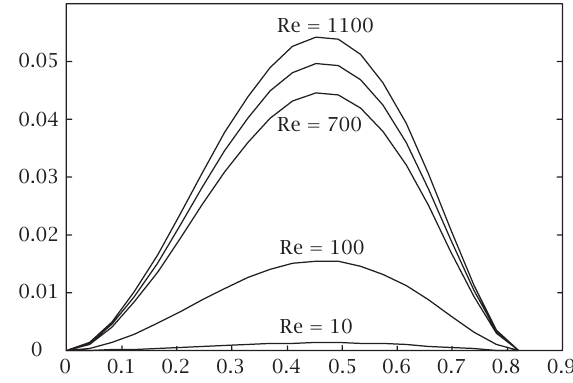
Figure 4.4. Variation of the radial velocity component with radial distance at the equator.